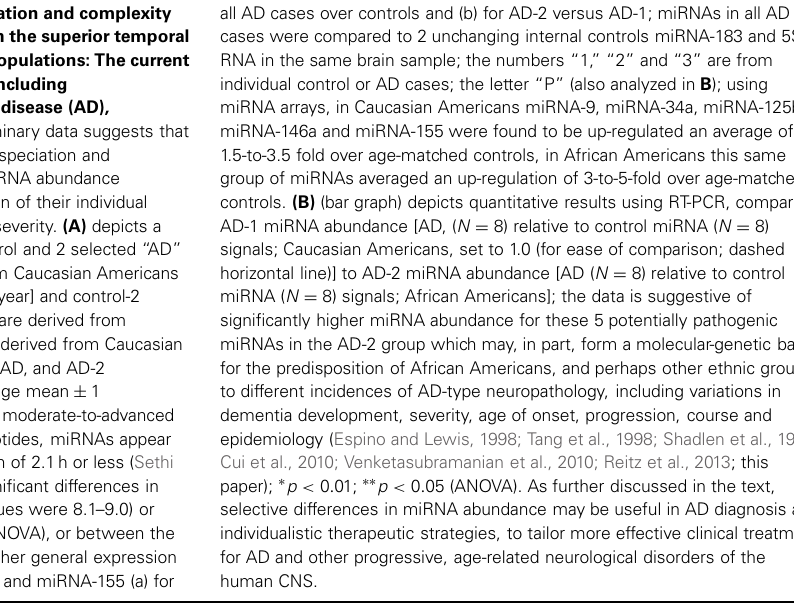
all AD cases over controls and (b) for AD-2 versus AD-1; miRNAs in all AD cases were compared to 2 unchanging internal controls miRNA-183 and 5S RNA in the same brain sample; the numbers “1,” “2” and “3” are from individual control or AD cases; the letter “P” (also analyzed in B ); using miRNA arrays, in Caucasian Americans miRNA-9, miRNA-34a, miRNA-125b, miRNA-146a and miRNA-155 were found to be up-regulated an average of 1.5-to-3.5 fold over age-matched controls, in African Americans this same group of miRNAs averaged an up-regulation of 3-to-5-fold over age-matched controls. (B) (bar graph) depicts quantitative results using RT-PCR, comparing AD-1 miRNA abundance [AD, ( N = 8) relative to control miRNA ( N = 8) signals; Caucasian Americans, set to 1.0 (for ease of comparison; dashed horizontal line)] to AD-2 miRNA abundance [AD ( N = 8) relative to control miRNA ( N = 8) signals; African Americans]; the data is suggestive of significantly higher miRNA abundance for these 5 potentially pathogenic miRNAs in the AD-2 group which may, in part, form a molecular-genetic basis for the predisposition of African Americans, and perhaps other ethnic groups, to different incidences of AD-type neuropathology, including variations in dementia development, severity, age of onset, progression, course and epidemiology (Espino and Lewis, 1998; Tang et al., 1998; Shadlen et al., 1999; Cui et al., 2010; Venketasubramanian et al., 2010; Reitz et al., 2013; this paper); ∗ p < 0 . 01; ∗∗ p < 0 . 05 (ANOVA). As further discussed in the text, selective differences in miRNA abundance may be useful in AD diagnosis and individualistic therapeutic strategies, to tailor more effective clinical treatment for AD and other progressive, age-related neurological disorders of the human